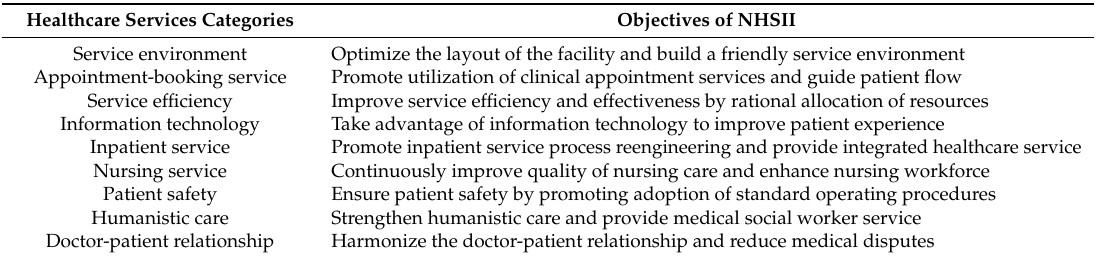
Table 2. Healthcare services categories and corresponding descriptions in the National Healthcare Service Improvement Initiative 2015–2017